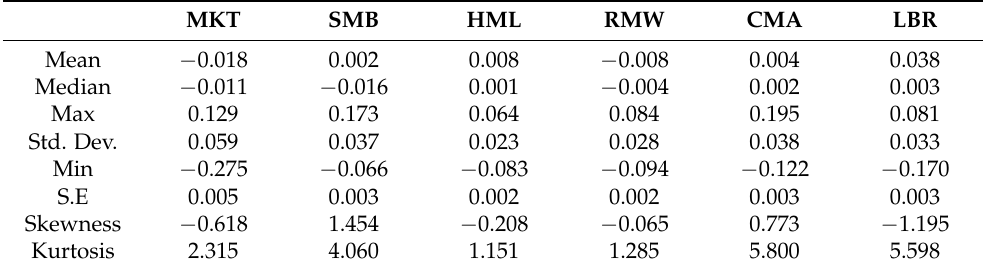
Table 2. Descriptive summary of the six factors.